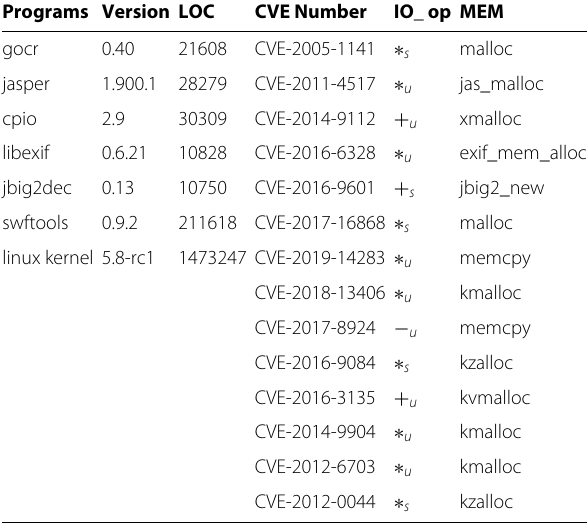
Table 5 Information of applications used in